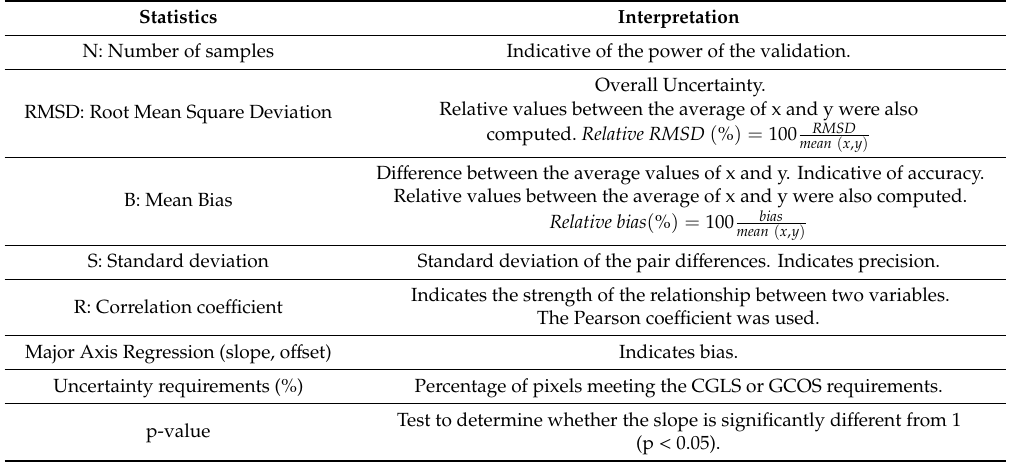
Table 3. Metrics computed for product validation, either comparison with ground measurements or intercomparisons of satellite products; x stands for the reference, and y stands for the estimated